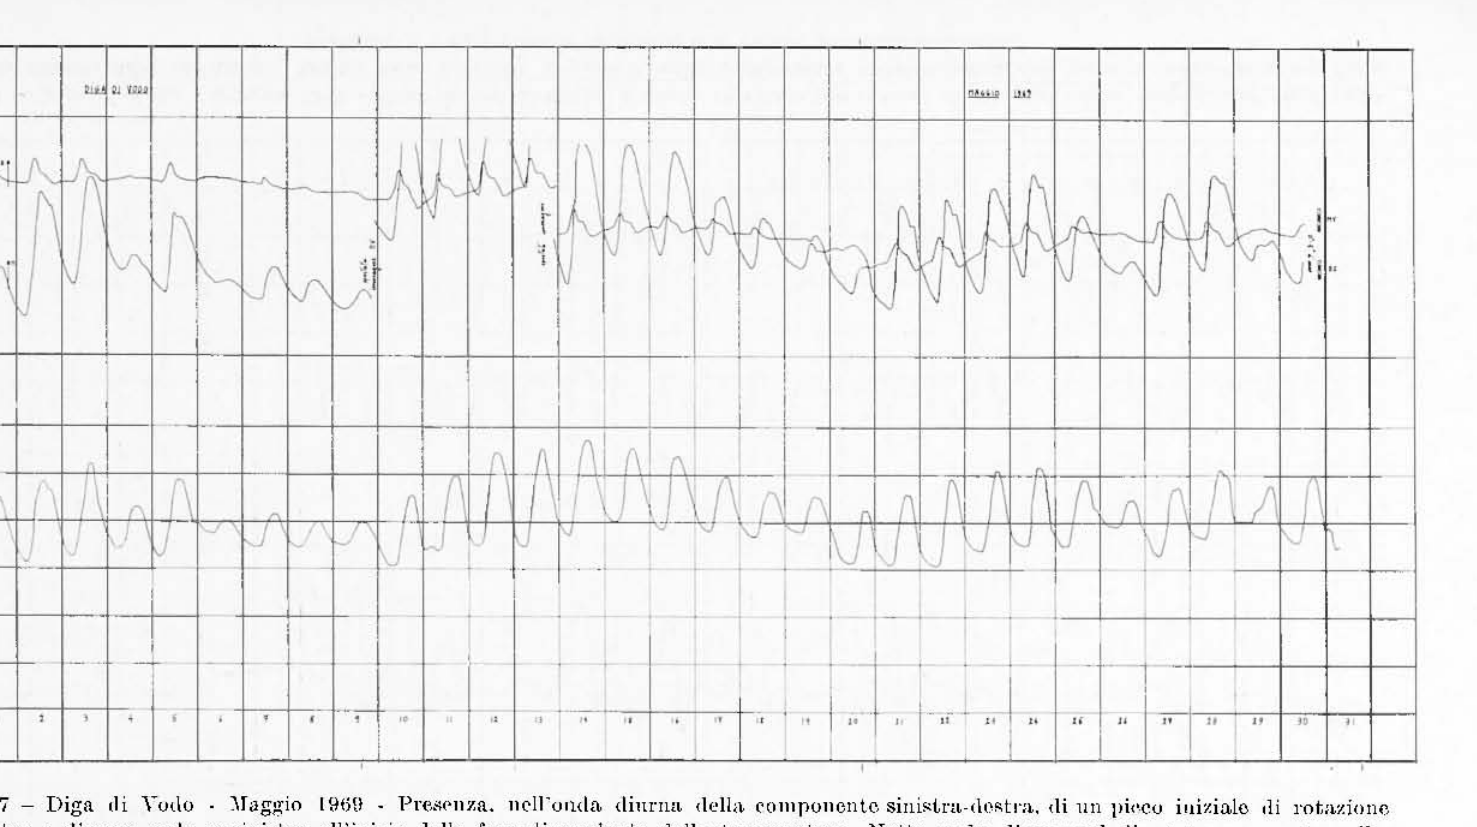
Fig. 'i - Diga (li YUl\O . 'ITilggio [!ehm· Pres('ll7.:l. llell"ullda. dinl"na ,Iella C'ompOllcnte silli"tm-(l()~tra" ,li Ull pi,'cu iniziale ,li rota.zione il doslm e di llnll. coda n. sini.~tra all'iniziu tlella fa..~{'. flisco!ldcllle ,Iella tOlllperat.llm. Notte ulUlo ,liurIle Il!',1 c1illUgr:lllllll:l monte_vallo. Cont.rasti aceclltuuli ill ambo le compollonli dUYlltì alle variazioni ,Iella tnmperatllra doll'aria, che, in <.Jlle~tu ][l('~e, j,ro\"ocano